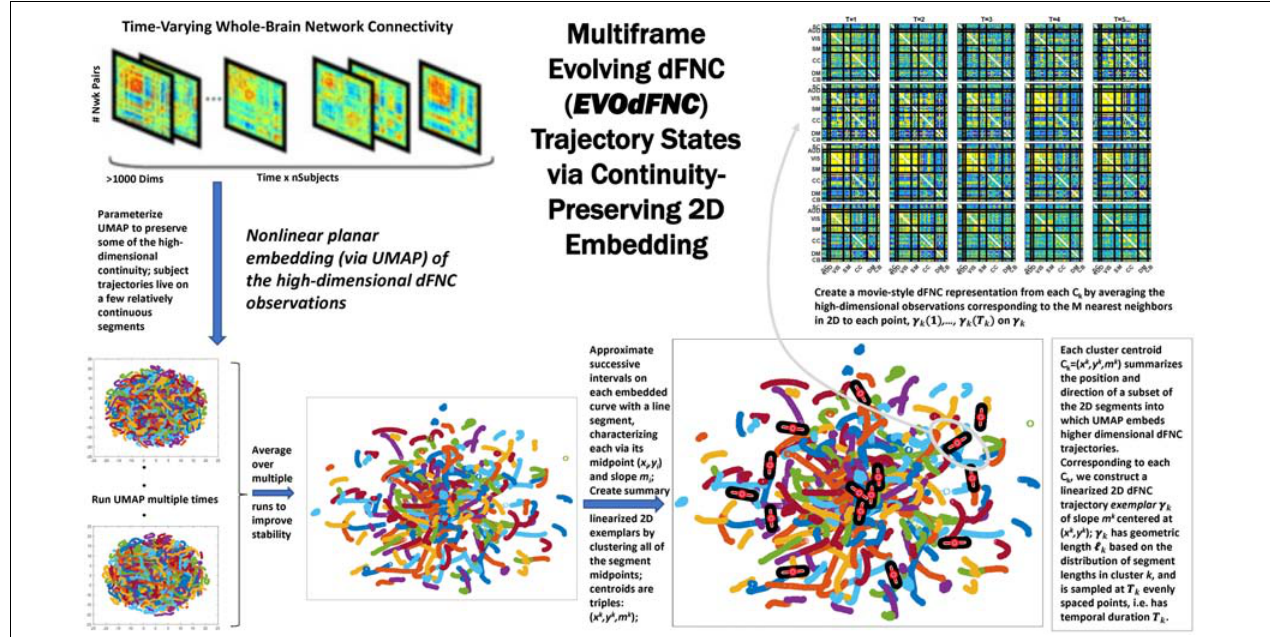
FIGURE 4 | Overview schematic exhibiting the pipeline for producing representative evolving multiframe high-dimensional states of dynamic functional network connectivity (EVOdFNCs). High-dimensional dynamic functional connectivity assessed as pairwise correlations on sliding windows through each subject’s GICA network timecourses (top left) are embedded into 2D using uniform manifold approximation and projection (UMAP). The embedding is done R times (bottom leftmost), then averaged over the R runs to improve stability (bottom second from the left). Continuous trajectories in the averaged embedding are treated as locally (i.e., sub-segments of temporal duration τ = 44 ) linear. Directional and positional trends in the 2D dynamics are then captured by clustering the midpoints and slopes of these local linearizations, resulting in a set of summary tangents to the embedded trajectories, linearized trajectory exemplars (bottom right). The exemplars are then “inverted” back to the native dFNC dimensionality, as EVOdFNCs, by associating to each of τ evenly points along an exemplar, the average of the high-dimensional dFNCs that map to that point’s n nearest neighbors in 2D (top